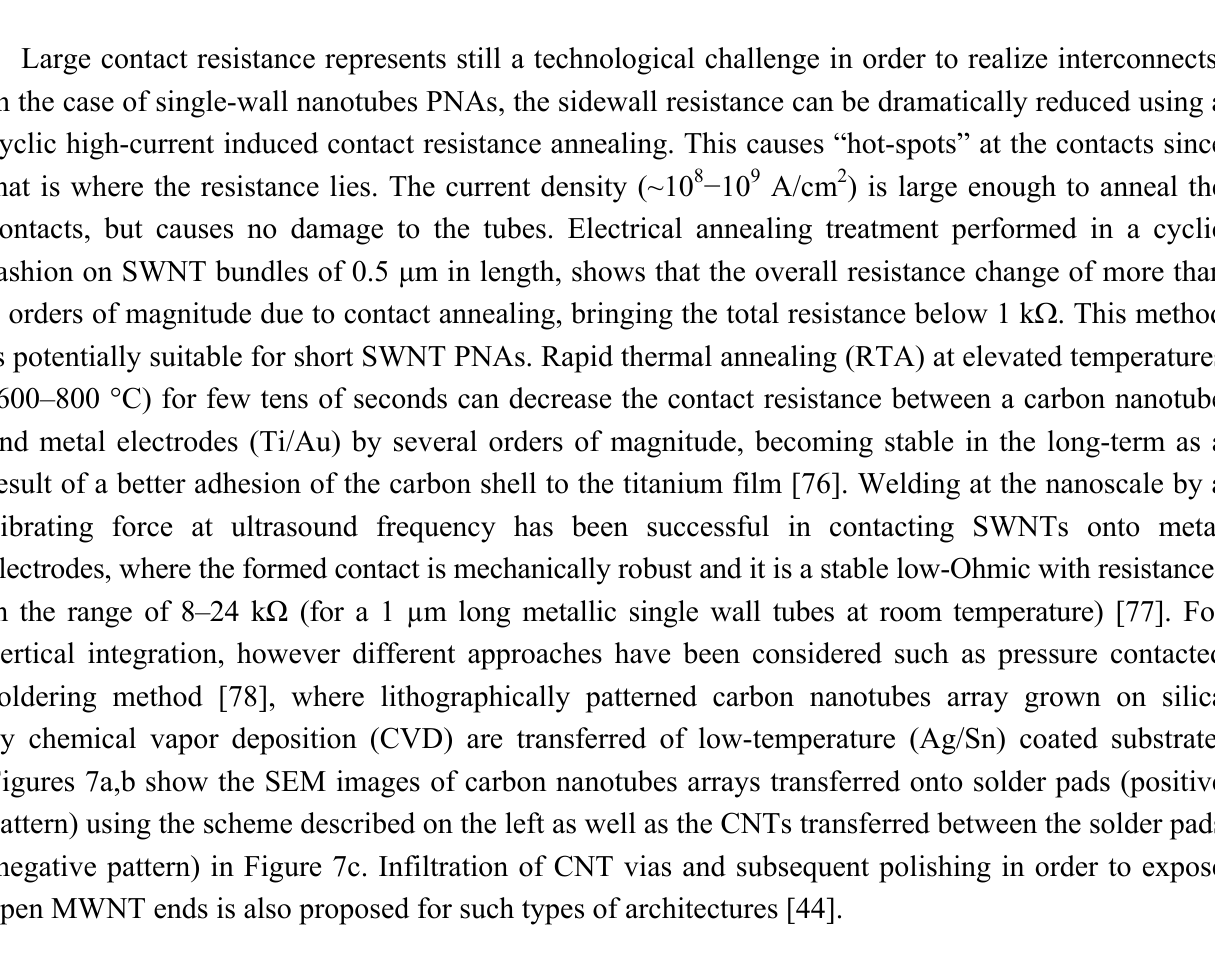
Figure 7. ( a , b ) SEM images of CNTs transferred onto solder pads (positive